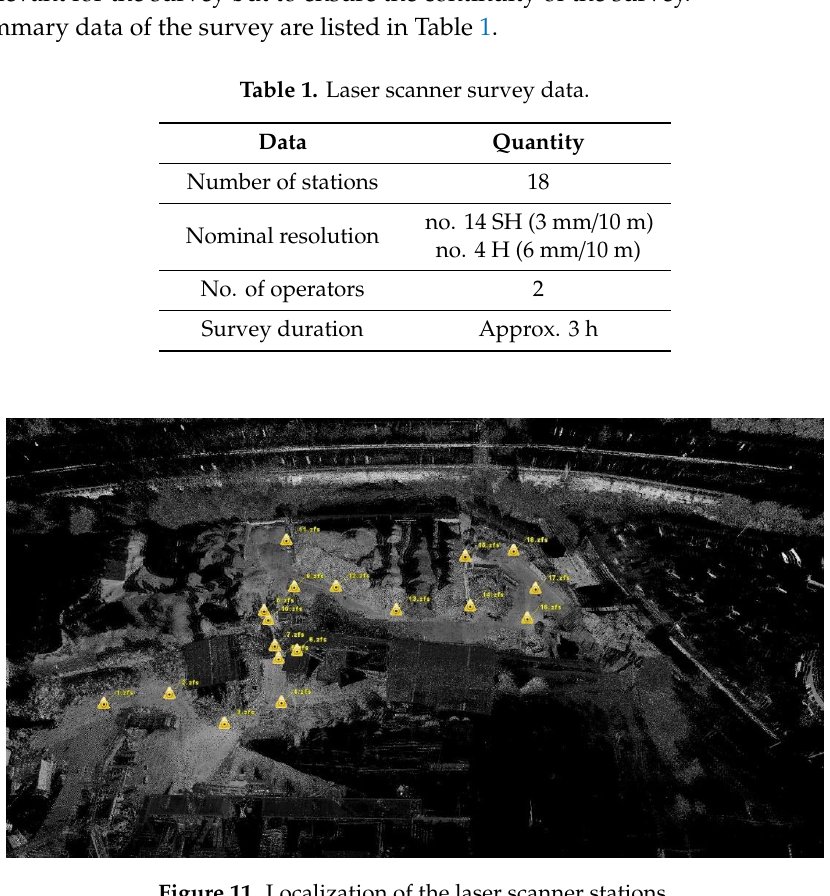
Figure 12. Flight plan used for the three flights.